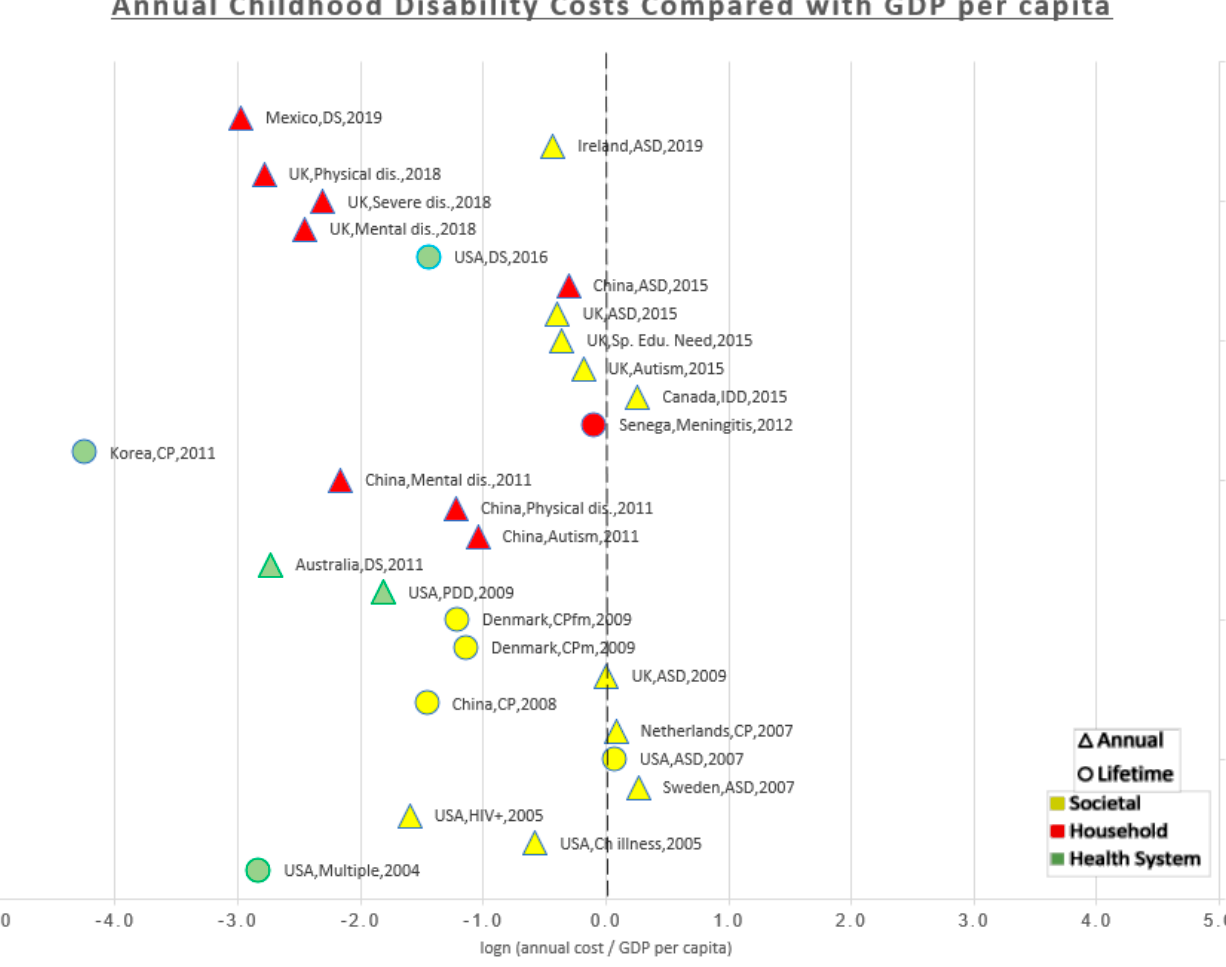
Figure 4. Annual childhood disability costs compared with GDP per capita. Care must be taken not to simply compare the costs from different studies as there are considerable methodological differences between them, this graph is just a way of summarizing these differences.